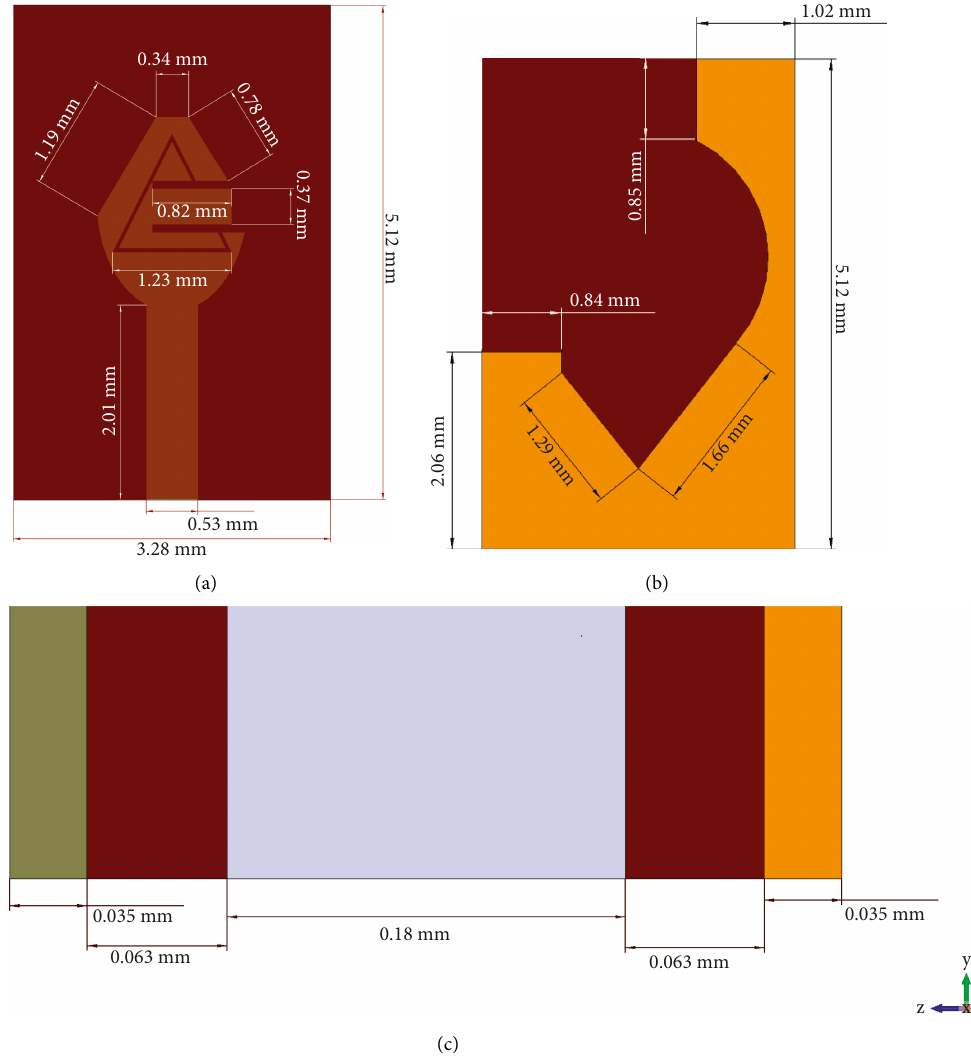
Figure 2: Antenna dimensions (a) front dimensions, (b) back dimensions, and (c) layer